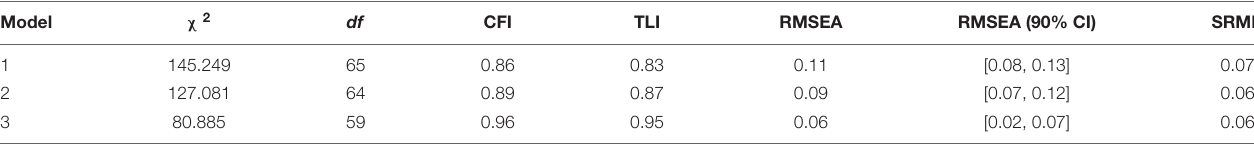
TABLE 3 | Summary of the fit indices for the estimated models using the RSES and the SESS items ( N = 136). Model